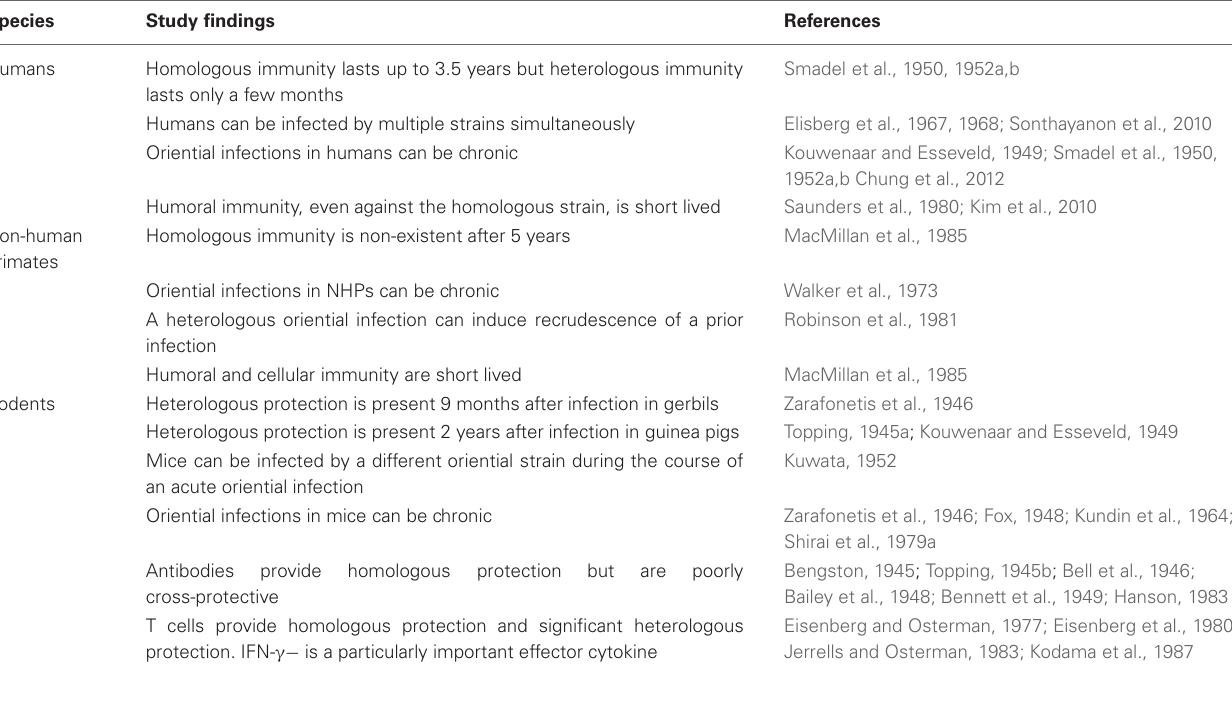
Table 3 | Adaptive immune response against O. tsutsugamushi .